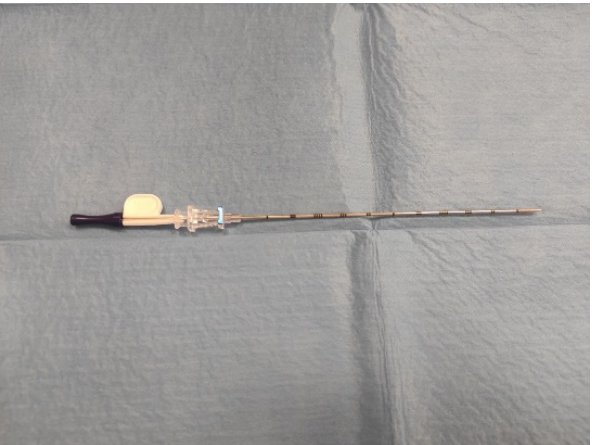
Figure 1. The 18-gauge Magseed introducer.